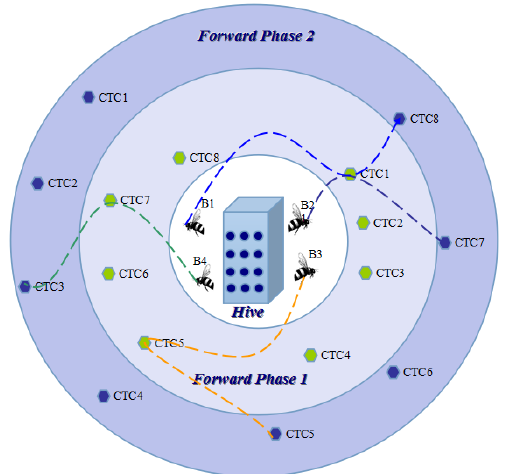
Figure 2. The forward Phase of our BCO implementation